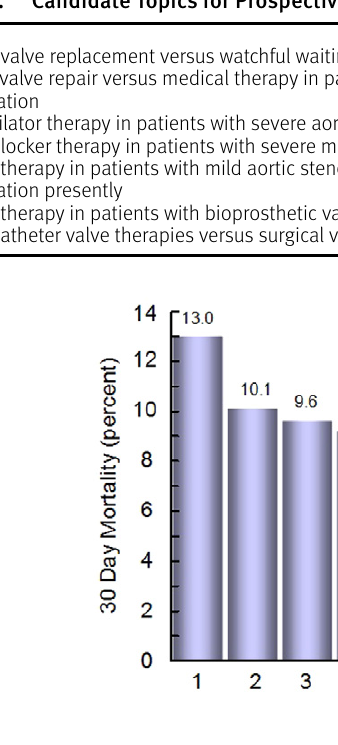
Figure. 1 Relationship between hospital volume and in-hospital mortality for aortic valve replacement (AVR) in patients 65 years or older in the US Medicare system. There is nearly a linear relationship between hospital